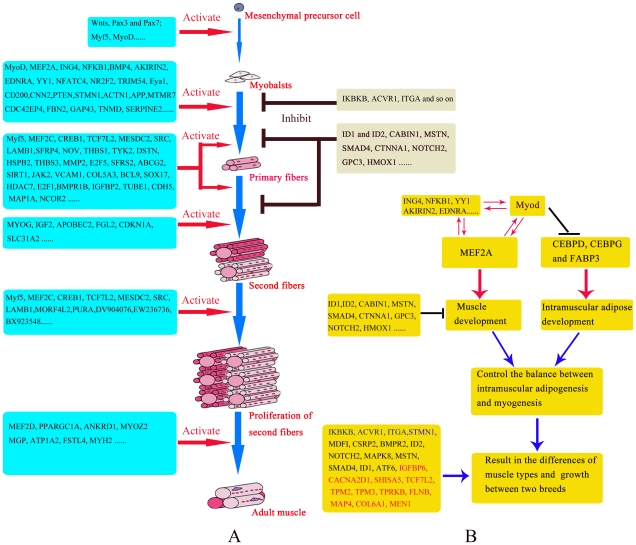
The molecular regulation of myogenesis and the model for MyoD controls intramuscular adipogenesis and myogenesis.Red dots indicate the promoting roles of these genes in myogenesis and blank striping indicate the repressing roles. (A) The probable roles of DE genes in regulating myogenesis (B) The novel model for MyoD controls the balance between intramuscular adipogenesis and myogenesis.